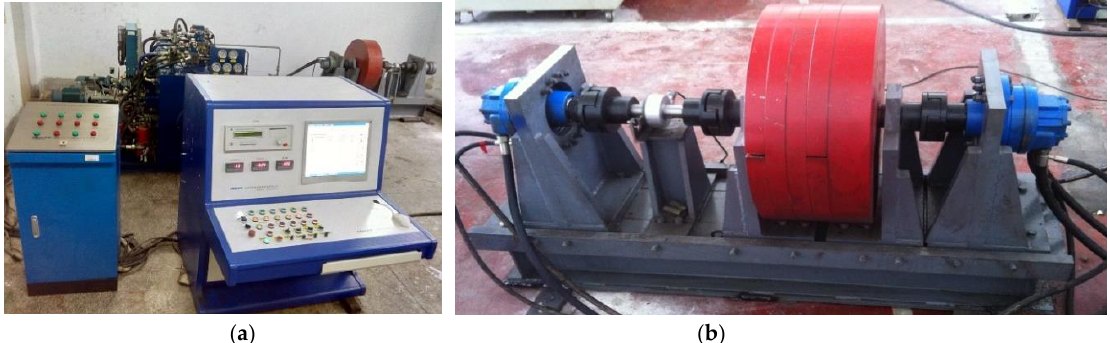
Figure 4. Experimental system. ( a ) A view of the experimental system; ( b ) Loading system. Table 1. System configuration.